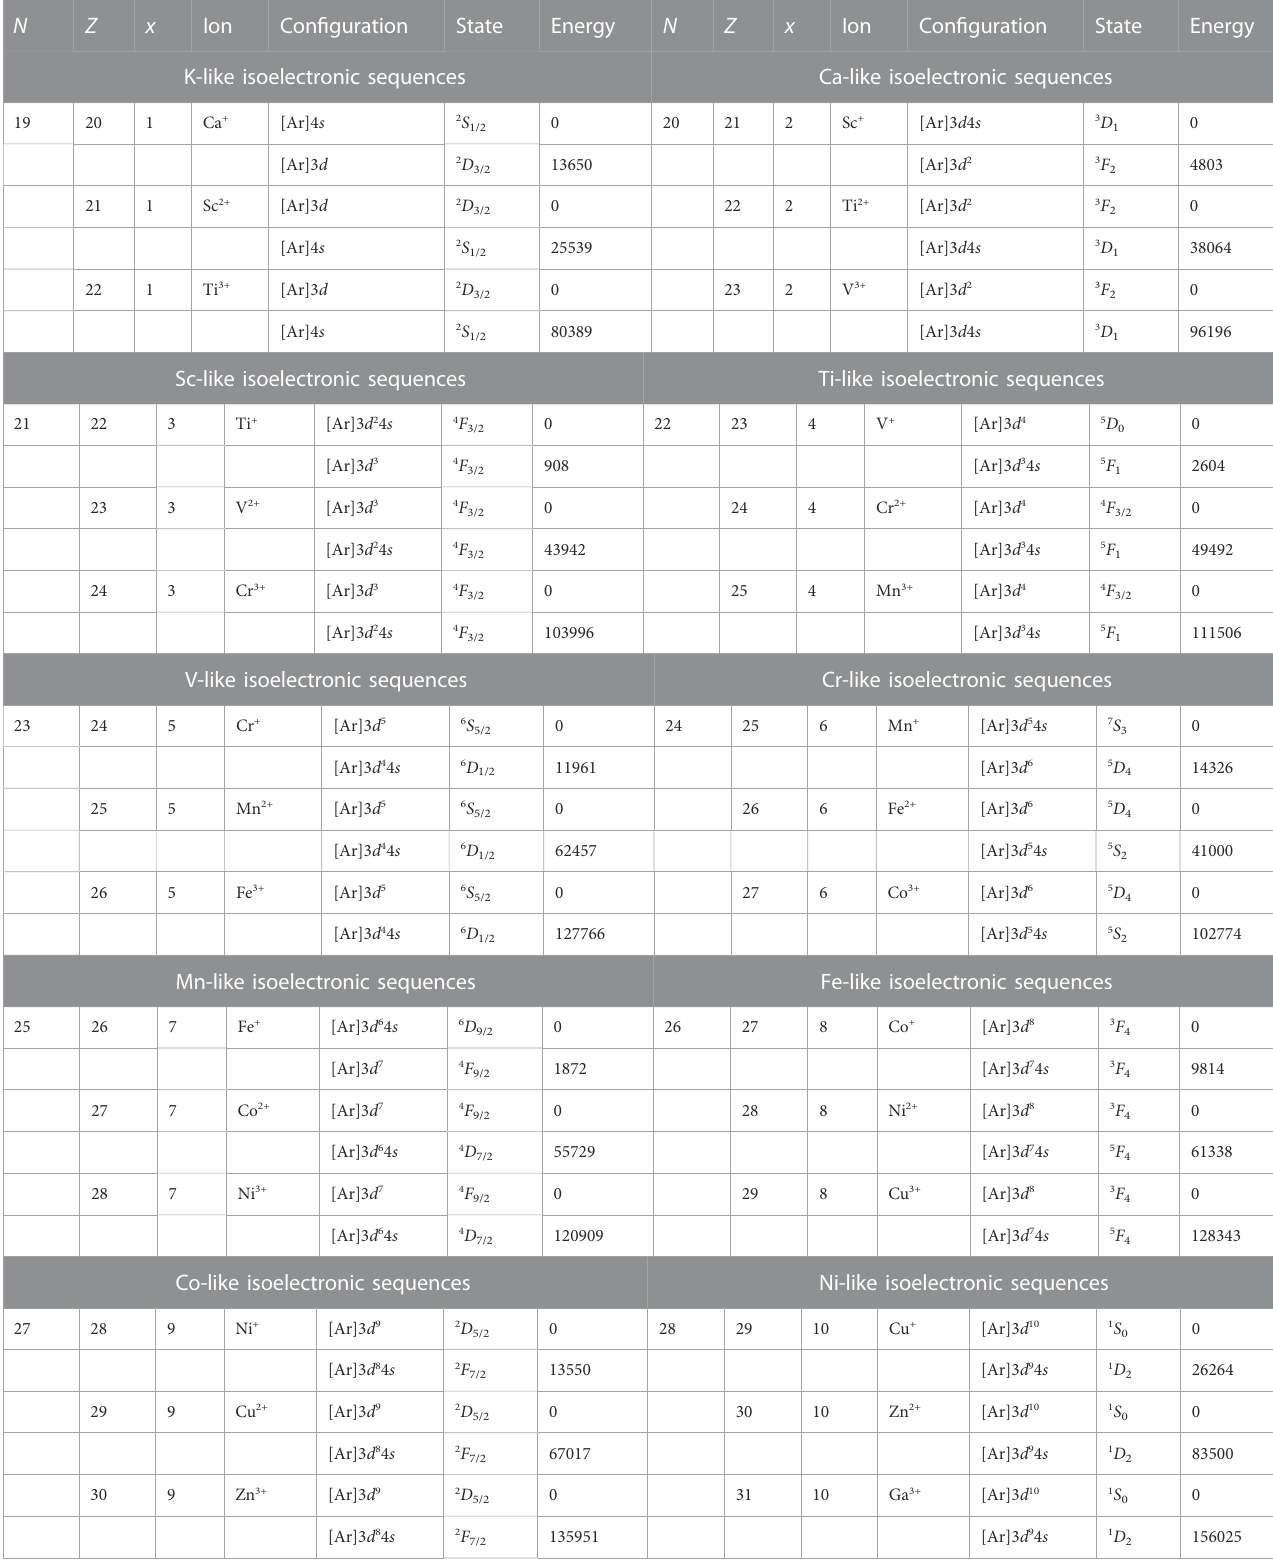
Sc-like isoelectronic